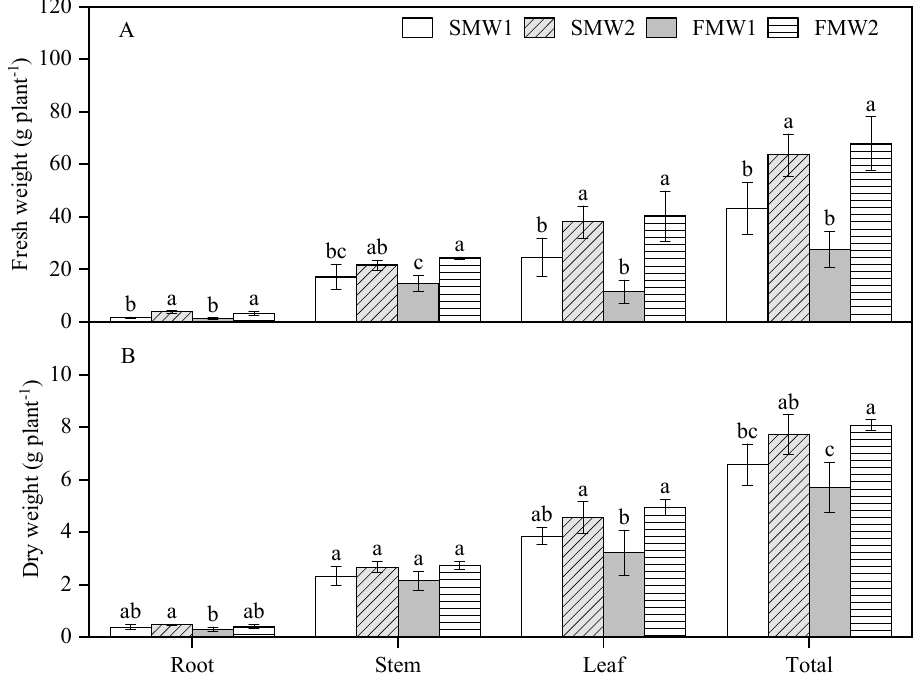
Figure 3. Effects of different treatments on the fresh weight (FW) ( A ) and dry weight (DW) ( B ) of tomato organs on the 21st day after treatment. Values are the mean ± SD (n = 3). Duncan’s multiple-range test was used to test for differences among treatments at the p < 0.05 level. Different lowercase letters above the columns indicate significant differences among treatments within the same organ.